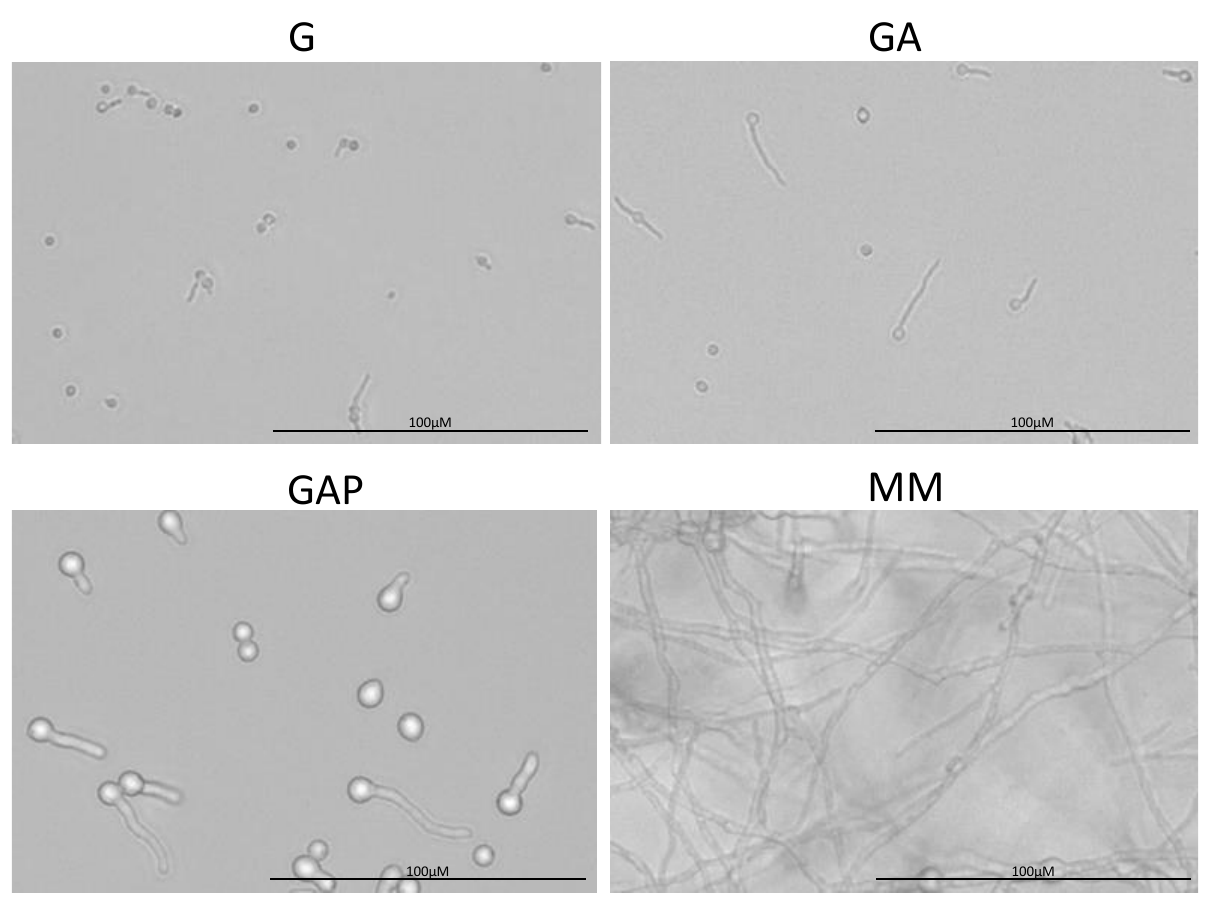
Figure 3. Morphology of the conidia germinating in G (glucose), GA (glucose + ammonium tartrate), GAP (glucose + ammonium tartrate + phosphate) and complex MM for 24 h. Conidial swelling was not correlated with the percentage of germinating